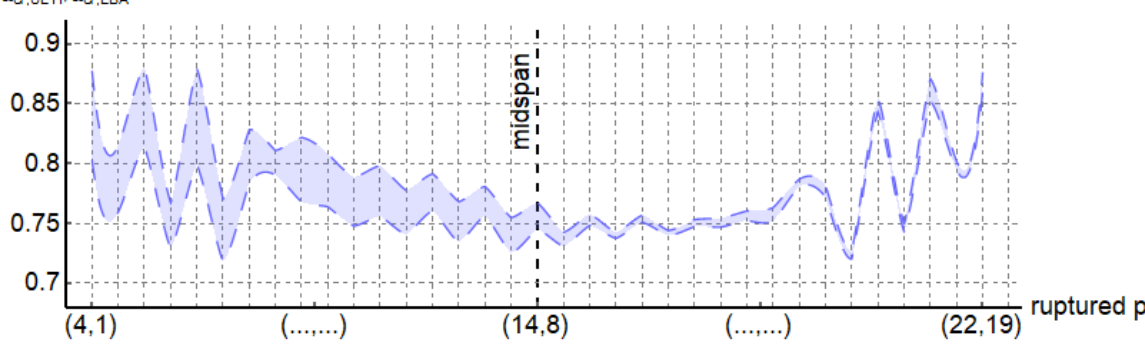
Figure 23: The range of ULTI-to-LBA critical load factor ratios for breaking two nearest hangers at once. The first number in brackets on the horizontal axis corresponds to the right-skewed hanger and the second number to the left-skewed